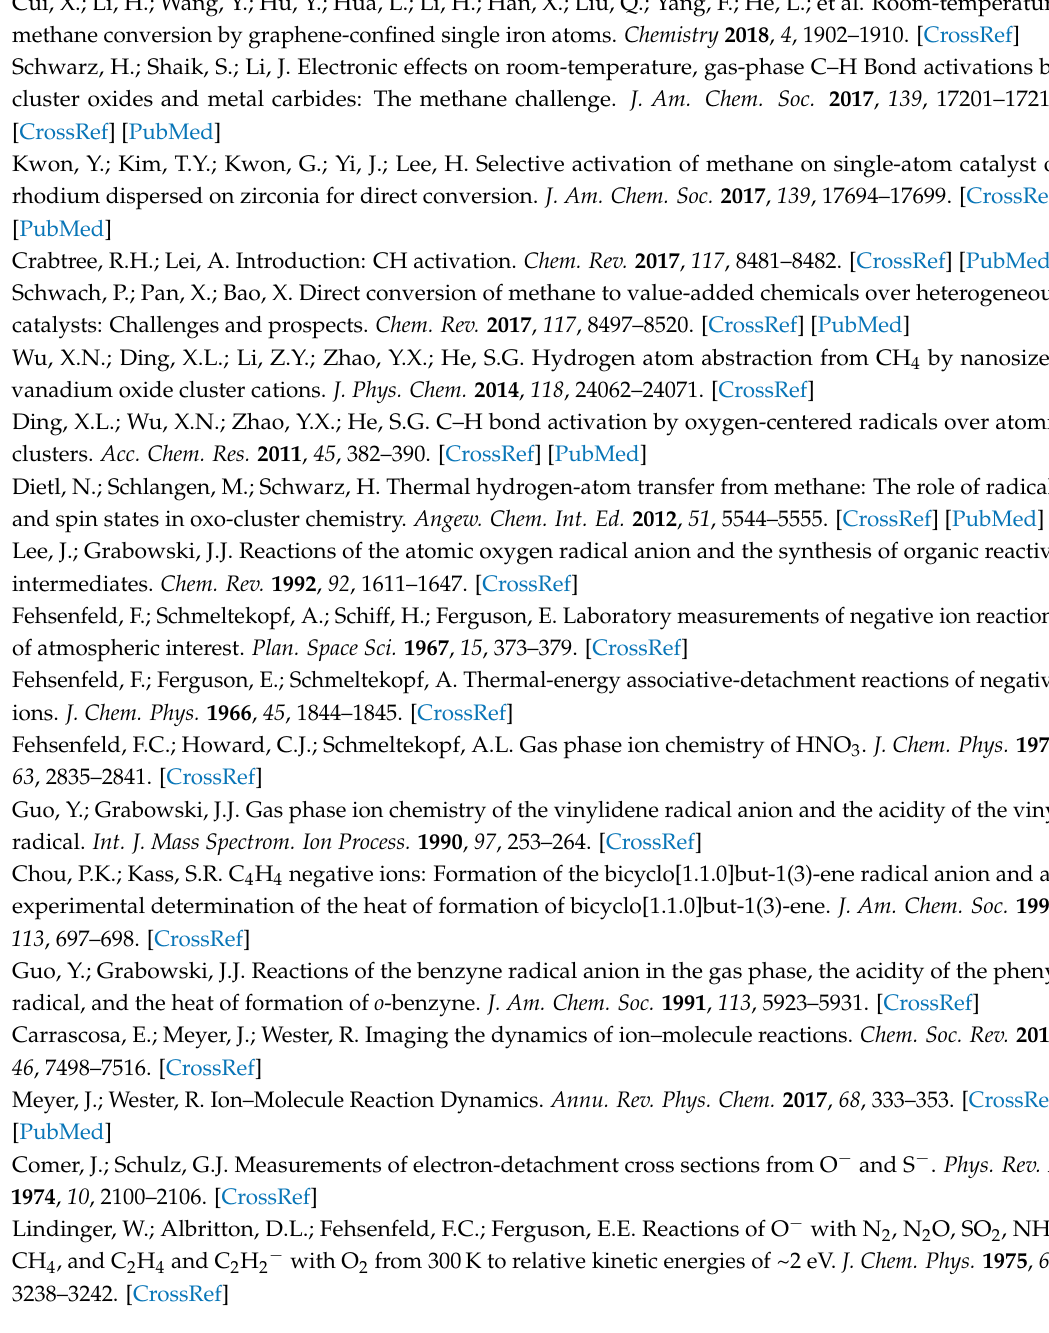
S3: Geometric parameters of methane molecule at the 10 moments of vibration, Table S4: The speeds (m/s) of individual atoms of methane molecule at the 10 moments of